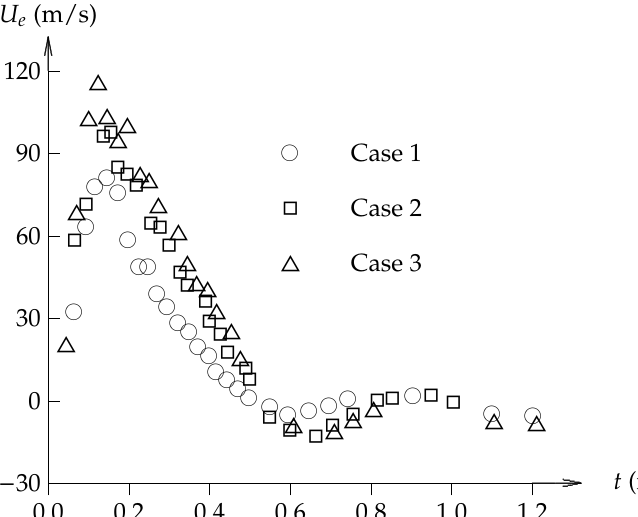
Figure 25. Jet exit velocity versus time at fixed f d .